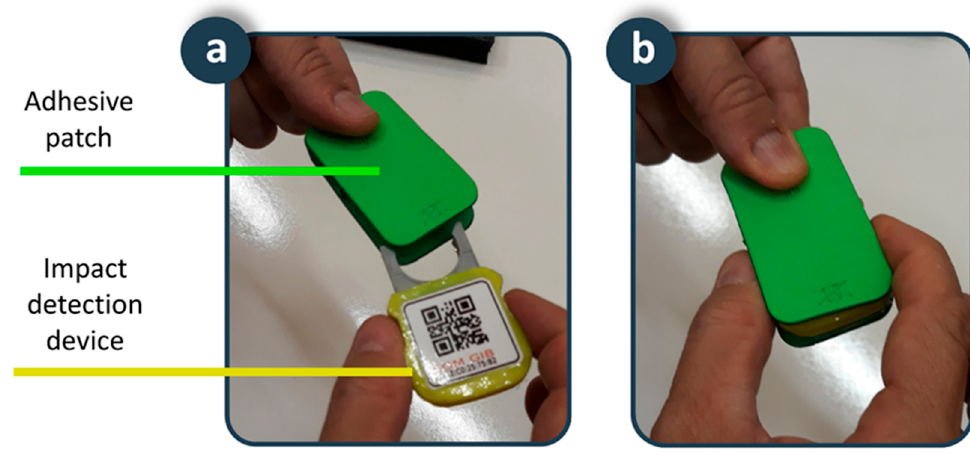
Figure 4. Smart sensor: ( a ) Adhesive patch and impact detection device; ( b ) Detail of the coupling.